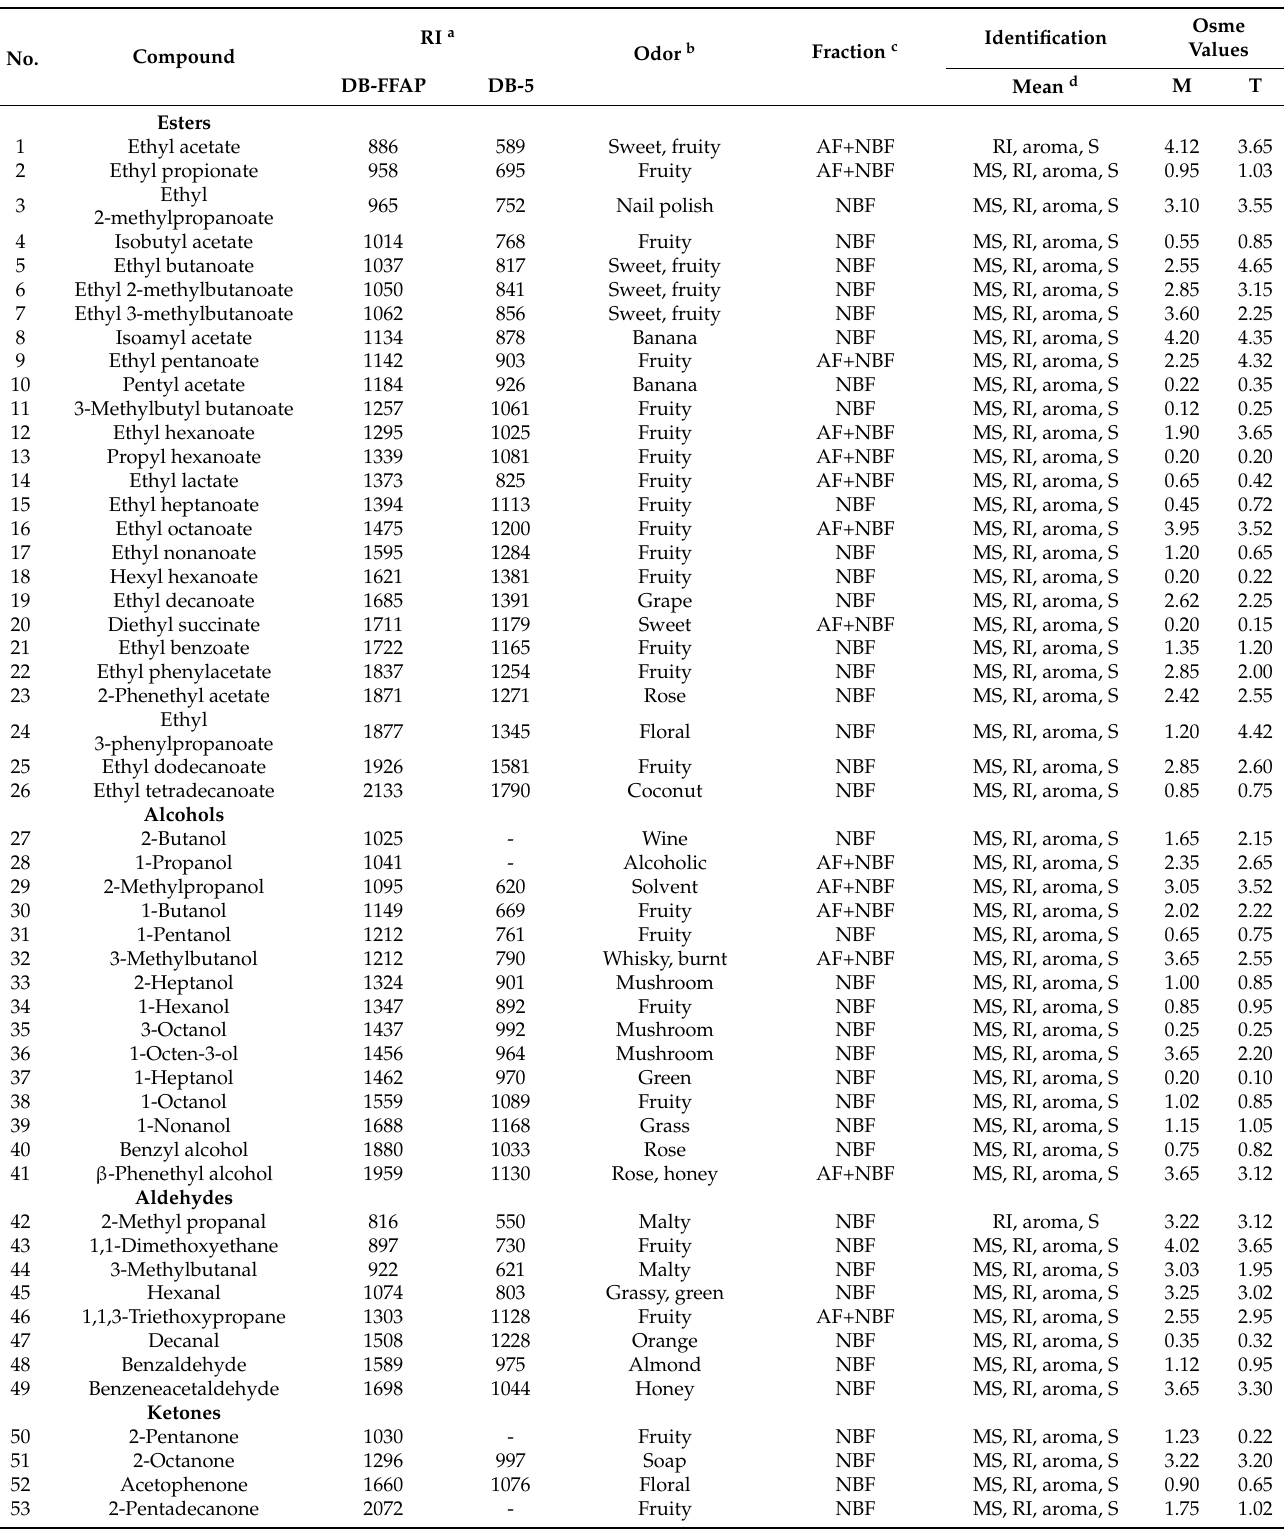
Table 1. Aroma compounds in Chinese xiaoqu Baijiu identified by gas chromatography-olfactometry (GC-O) and gas chromatography-mass spectrometry